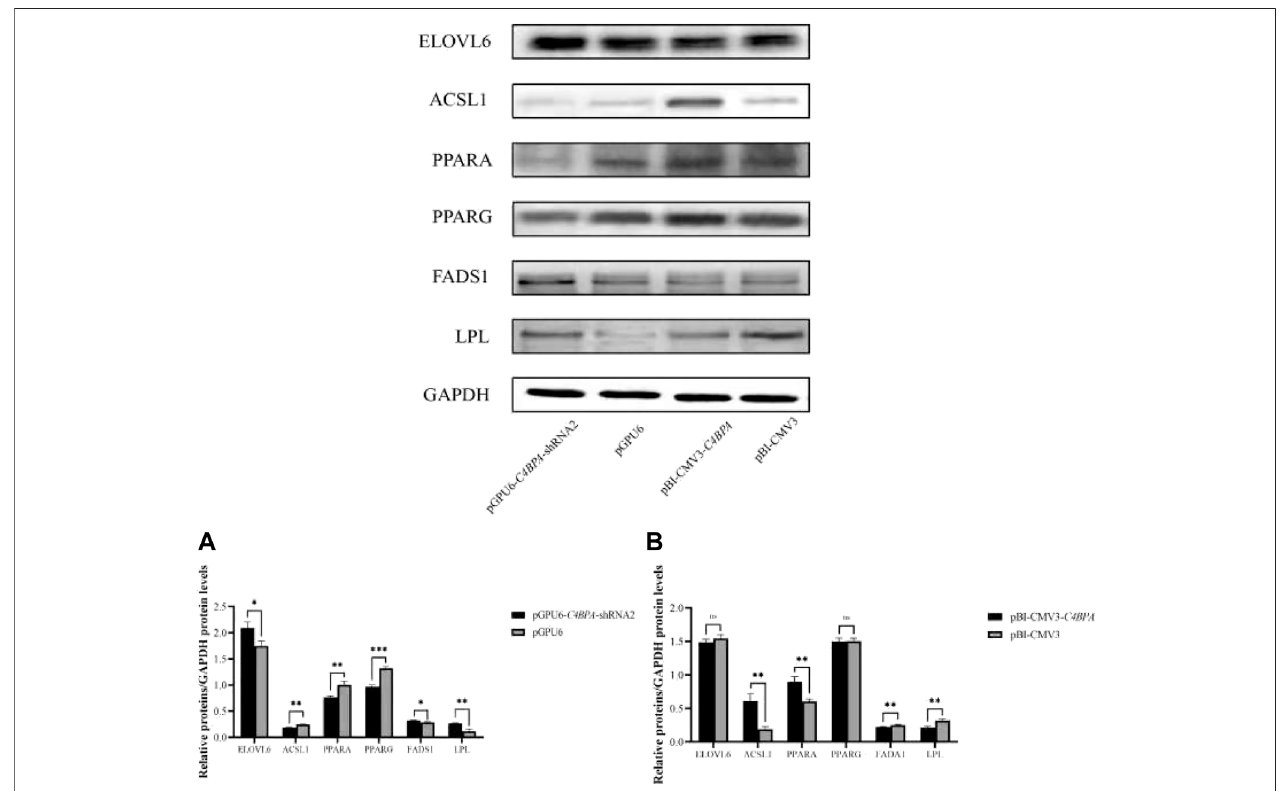
FIGURE 12 | Relative protein expression of the lipid metabolism-related genes in bMECs. (A) Relative protein expression of lipid metabolism-related genes in bMECs after transfection with pGPU6- C4BPA -shRNA2. (B) Relative protein expression of lipid metabolism-related genes in bMECs after transfection with pBI-CMV3- C4BPA